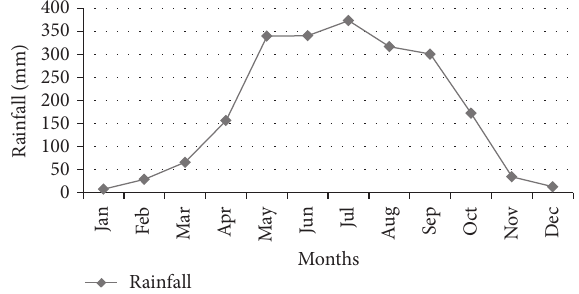
Figure 5: Monthly average rainfall in mm in Dhaka City.